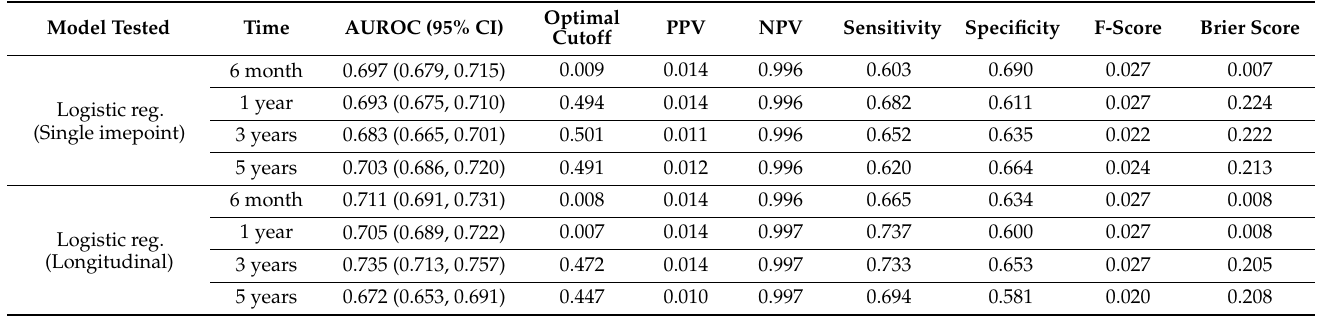
Table 2. Results of prediction models. (AUROC = Area Under the Receiver Operating Curve, PPV = Positive Predictive Value, NPV = Negative Predictive